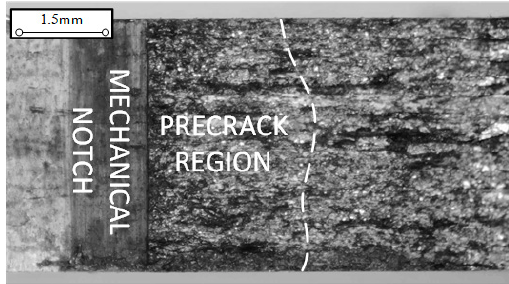
Figure 9. Macroscopic view on the fracture surface of the broken CT specimen (R = 0.5).